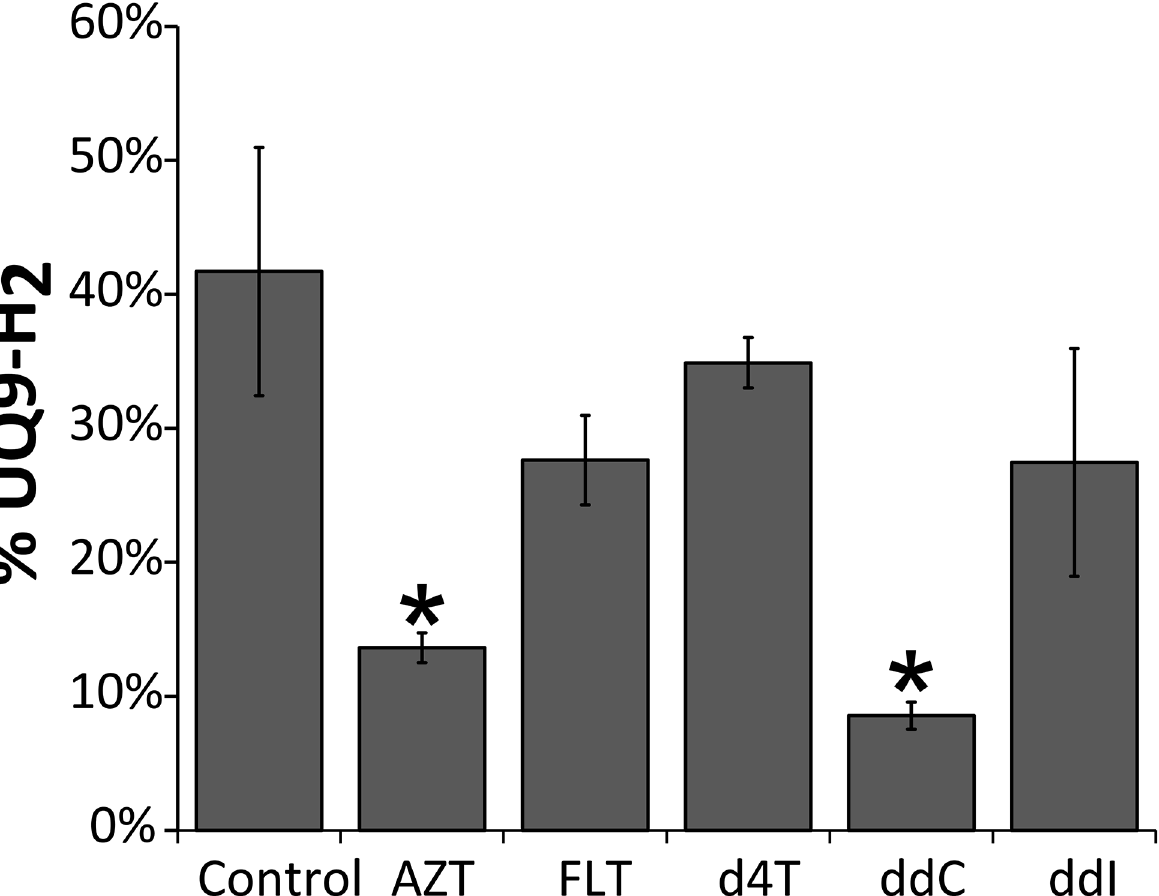
Fig 4. Quinone redox status is altered by some NRTIs. The redox state of the UQ 9 pool is presented as percentage reduced (i.e. UQ 9 -H 2 ) of the total UQ 9 pool. Error bars indicate standard error. * = P (cid:1)